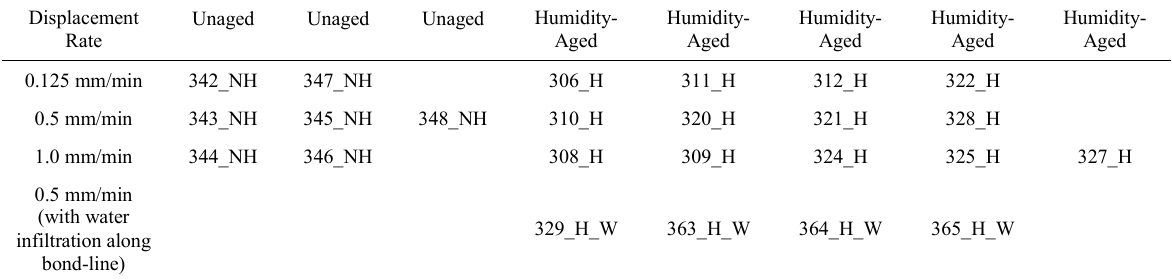
Table 3: Details of pre-test conditions for 24 samples